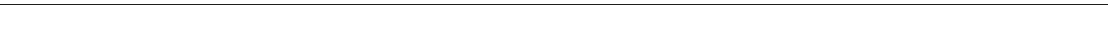
Fig. 1 Differentiation-state heterogeneity is enriched in the triple negative and basal-like subtypes. a Representative IF images of treatment-naïve primary breast cancers: “ luminal ” (ER + /PR + /HER2 − ), HER2 + (ER + / − /PR − /HER2 + ), and triple negative (ER − /PR − /HER2 − ), scale bars = 100 μ m. b The frequency of six epithelial cell states is shown for each tumor region in a vertical scatterplot with accompanying Shannon diversity index and ER, PR, and HER2 status. Luminal (L), HER2 + (H), and TN (T) tumor regions are arranged left to right by increasing Shannon index, regions of the same tumor denoted by “ a, b, c ” e.g., L2a, L2b, L2c. c Graph comparing Shannon index between tumors of different hormone receptor subtype (multiple regions of individual tumors are averaged if available), asterisks denote signi fi cance * P < 0.05, ** P < 0.01. SEM shown. d IF images of PDX tumors with low (left panels) and high (right panels) Shannon indices stained for DAPI (white), Ku80 (yellow), K19 (blue), K14 (green) and VIM (red), scale bars = 100 μ m. e The frequency of eight tumor cell states based on K19, K14, and VIM expression is shown for 31 PDX tumors in a vertical scatterplot with accompanying Shannon index. Patient ER, PR, and HER2-receptor status and intrinsic molecular subtype is shown. Tumors arranged left to right by increasing Shannon index. f , g Graphs of Shannon index, comparing tumors with differing receptor-positivity status and molecular subtype. * P < 0.05, **** P < 0.0001. SEM shown. h IF images of BCCLs with differing molecular subtypes, scale bars = 100 μ m. i The frequency of eight cell states based on K19, K14, and VIM expression is shown for each BCCL in a vertical scatterplot with accompanying Shannon index, molecular subtype and Triple negative (TN) status is indicated (denoted by color, marked by black squares). Cell lines are arranged left to right by increasing Shannon index. j Graph of Shannon index, comparing TN and non-TN BCCLs, as well as different molecular subtypes. * P < 0.05, ** P < 0.01, *** P < 0.001, ns = not signi fi cant, SEM shown. k Heatmap of BCCL gene expression of 25 luminal, 25 myoepithelial, and 25 EMT-correlated genes. BCCLs are arranged by unsupervised clustering. Cell line molecular subtype is denoted by color. l Graph of the cumulative Z -score of the luminal, myoepithelial, and EMT genesets in BCCLs of different molecular subtype, basal-like (BL), claudin-low (CL), HER2 + (H2), and Luminal B (LB), * P < 0.05, ** P < 0.01, **** P < 0.0001, ns = not signi fi cant, SEM shown. m Graph of the variance between the mean geneset expression of the luminal, myoepithelial, and EMT genesets in BCCLs of different molecular subtype, asterisks denote signi fi cant difference in geneset variance, SEM shown. n Graph of the variance between HER2 + cell lines that are either of the L-HER2 or HER2E molecular